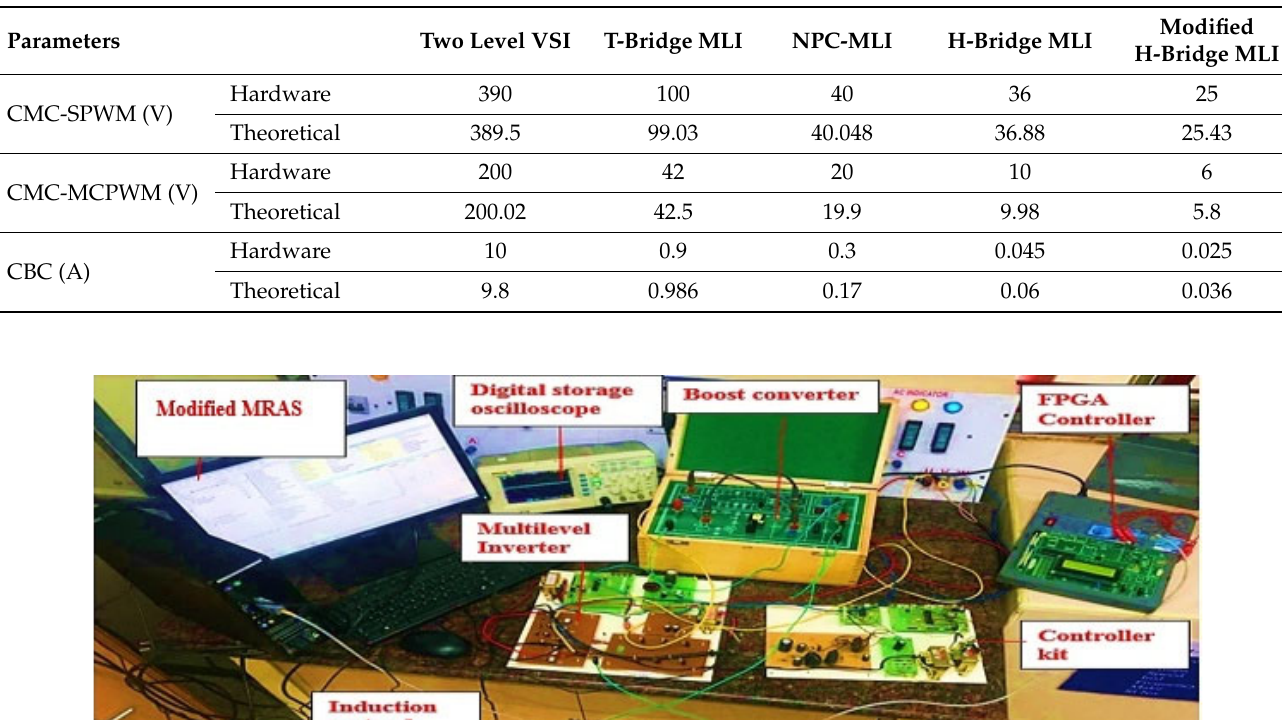
Table 6. Comparison of common mode voltage of induction motor drive.